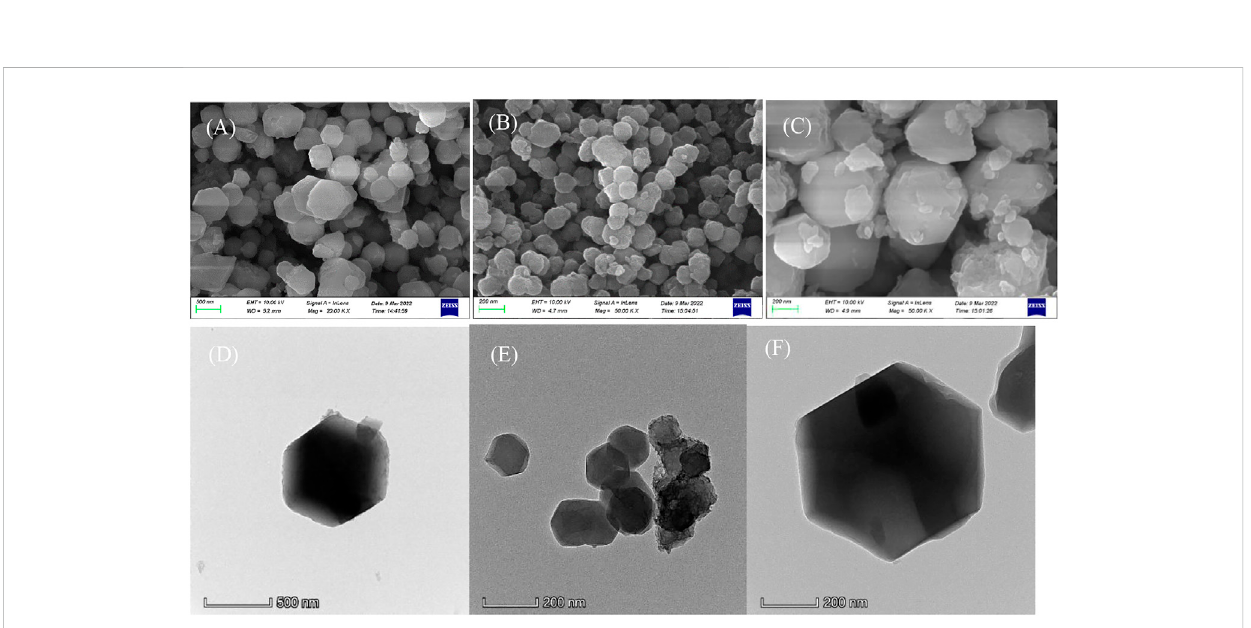
FIGURE 2 The SEM (A) and TEM (D) of ZIF-67 (CH 3 OH); SEM (B) and TEM (E) of ZIF-67 (C 2 H 5 OH); SEM (C) and TEM (F) of ZIF-67 (H 2